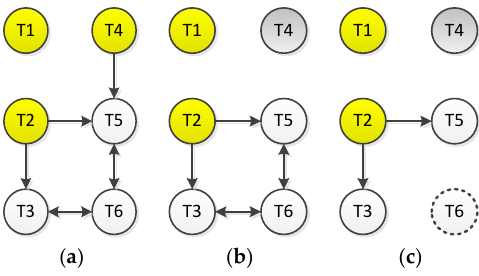
Figure 5. Non-optimal firefighting strategy for Scenario 2. ( a ) T1, T2, and T4 are all on fire. ( b ) T1 and T2 are on fire, and T4 is suppressed. ( c ) T1 and T2 are on fire, T4 is suppressed, and T6 is